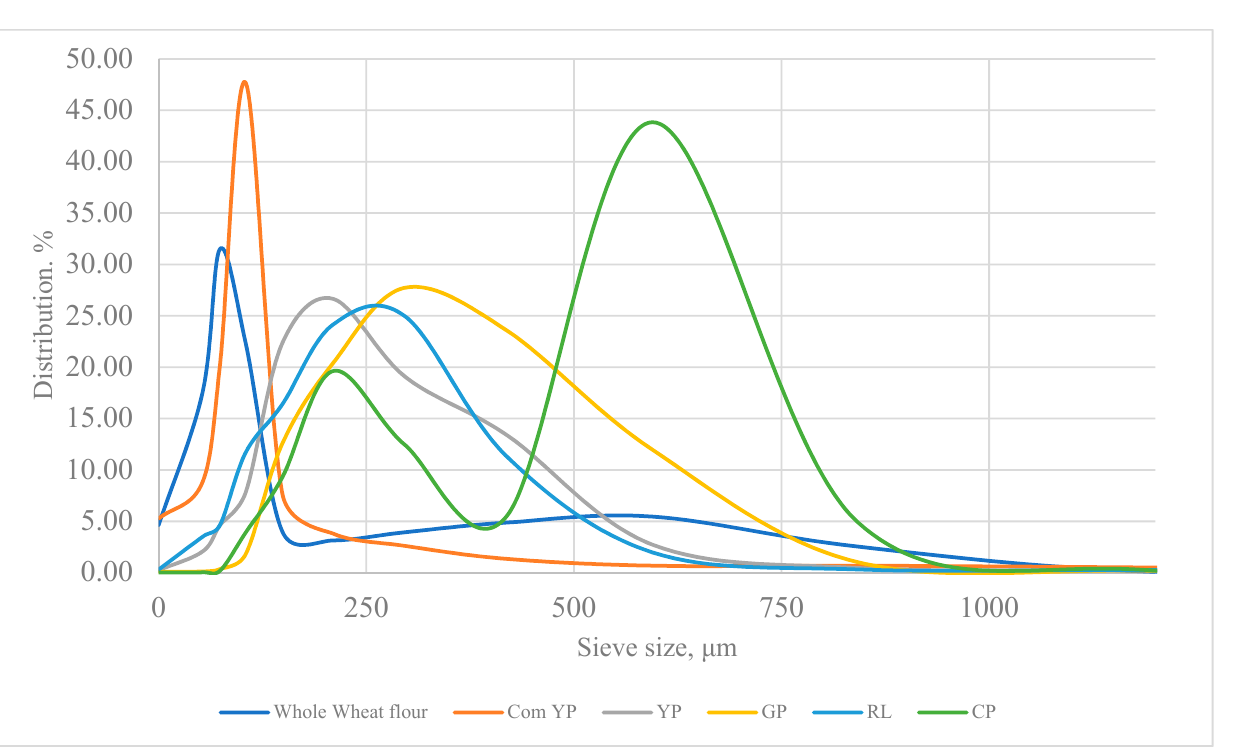
Figure 1. Particle size distribution of whole wheat flour and pulse flour. (CommYP, commercial yellow pea; YP, yellow pea; GP, green pea; RL, red lentil; CP, chickpea.).